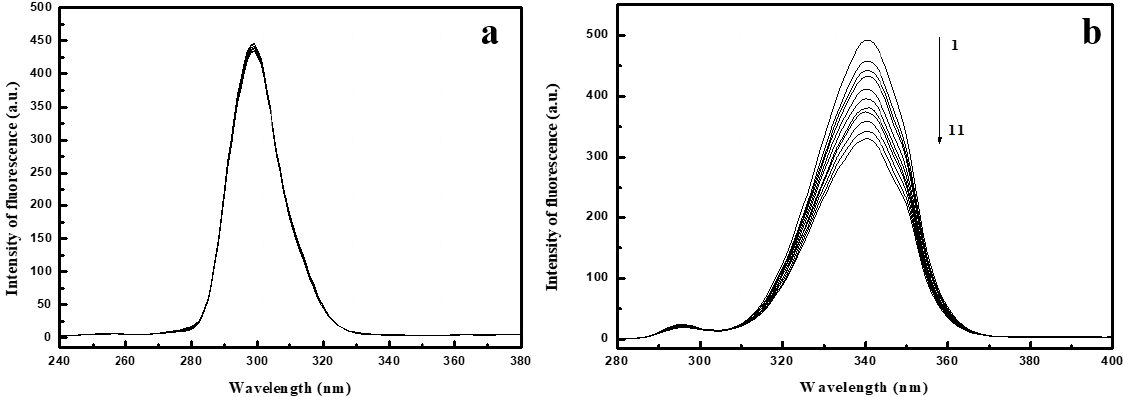
Figure 7. Synchronous spectra on Tyr ( a ) and Trp ( b ) of bovine serum albumin (BSA) in the presence of prothioconazole (PTC). c (BSA) = 2 × 10 −6 mol/L; c (PTC) = 2 × 10 −6 mol/L – 32 × 10 −6 mol/L (1–11).